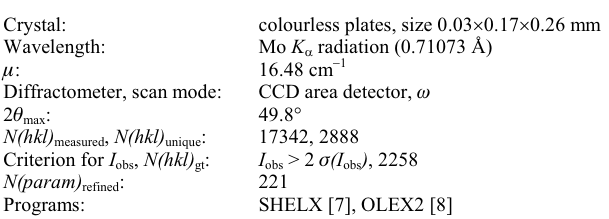
Table 1. Data collection and handling.